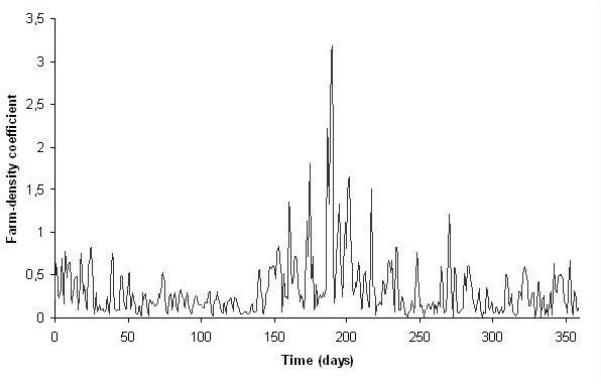
Fig. 5 . Daily variation of the farm-density